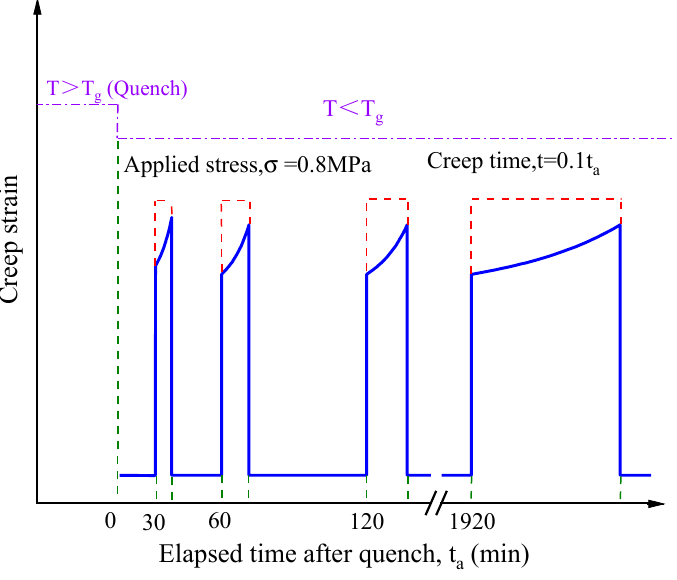
Figure 1. Sequence of tensile creep tests.